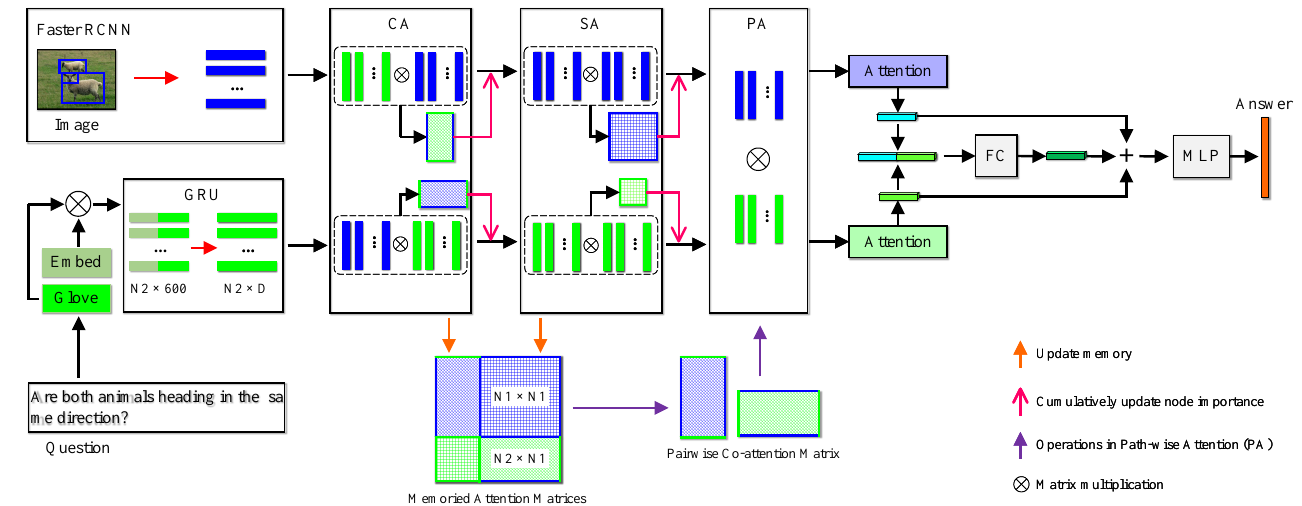
Figure 1. Illustration of the proposed Path-wise Memory Network(PAM) for visual question answering. It contains three main parts: (1) feature extraction, which contains a Faster-RCNN for image regions feature extraction, and a gated recurrent unit for question words feature learning; (2) a composite attention network composed of co-attention, self-attention, and path-wise attention, which is to dynamically swap and fuse information between the visual modality and the text modality; (3) an answer predictor which computes the final fused multi-modal feature and map features to the answer vector